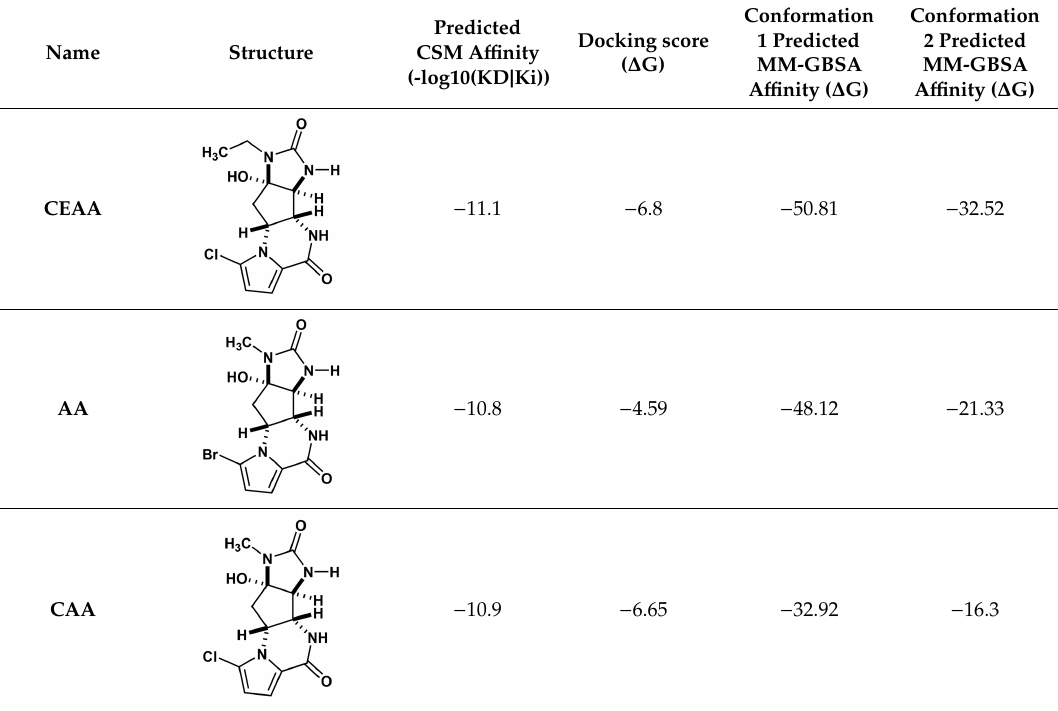
Table 1. Eight PTC binding compounds structures with their predicted affinity.